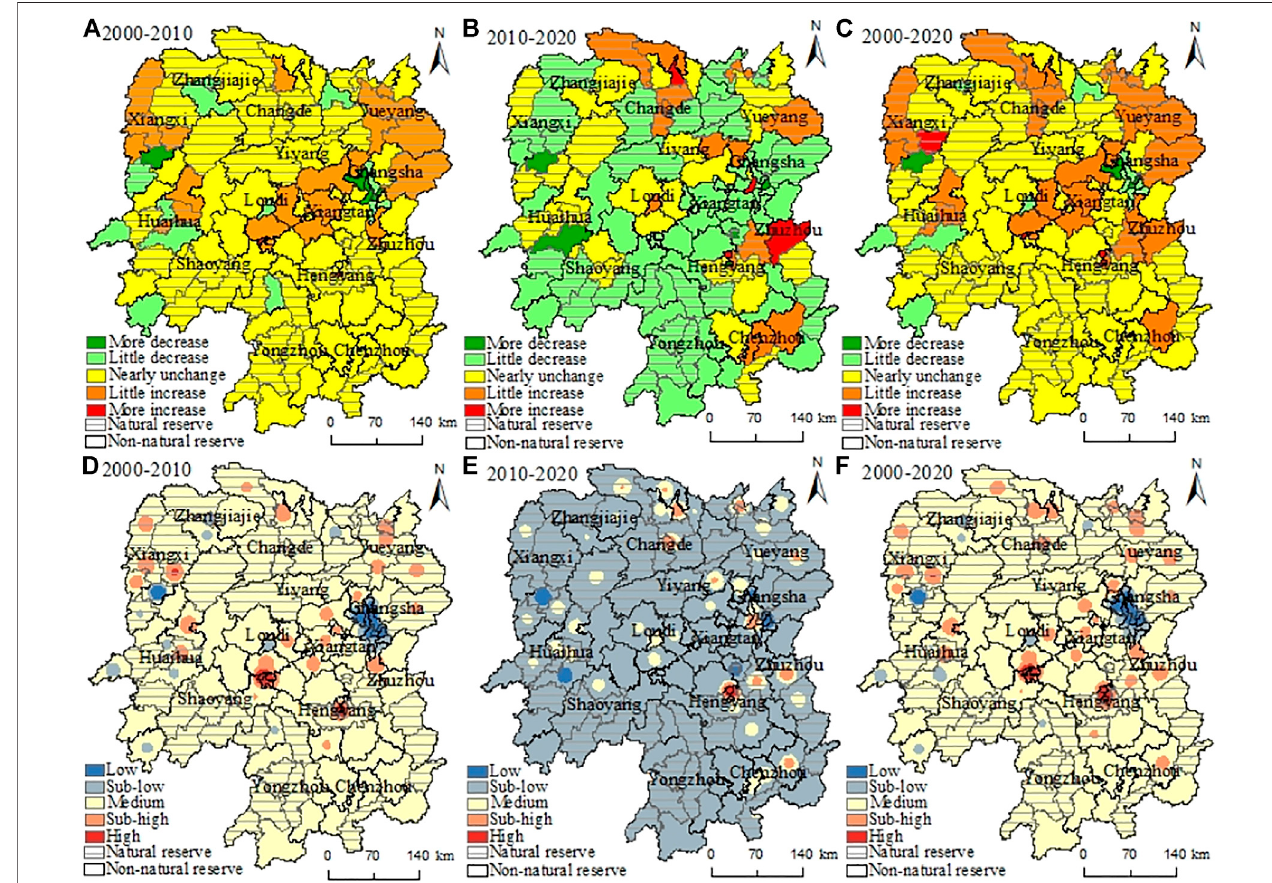
FIGURE4| ThechangedynamicsandkerneldensityoftheRRLareainnaturalreservesandnon-naturalreserves.[Panels (A – C) showthechangedynamicsofthe RRLareaincountiesofnaturalreservesandnon-naturalreservesin2000 – 2010,2010 – 2020,and2000 – 2020,respectively.Panels (D – F) showthekerneldensityofthe RRL area change in counties of natural reserves and non-natural reserves in 2000 – 2010, 2010 – 2020, and 2000 – 2020, respectively.]